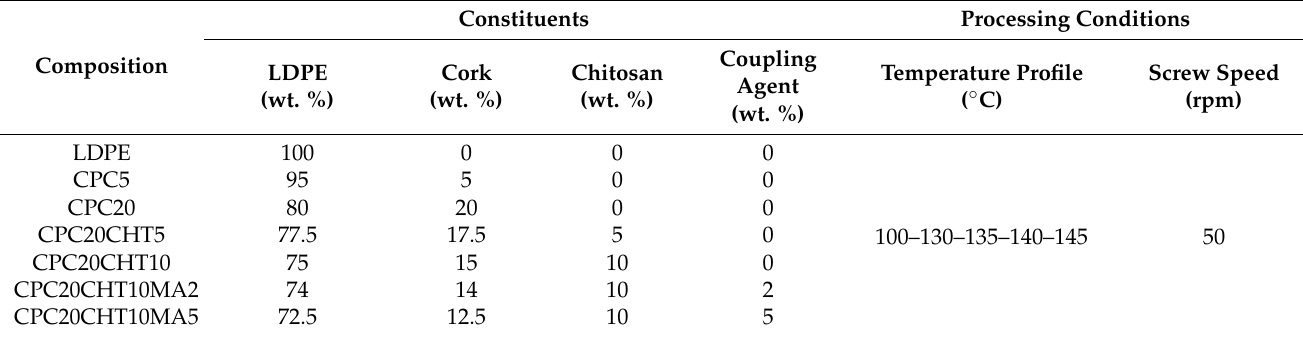
Table 2. The composition and processing parameters of the CPC obtained through